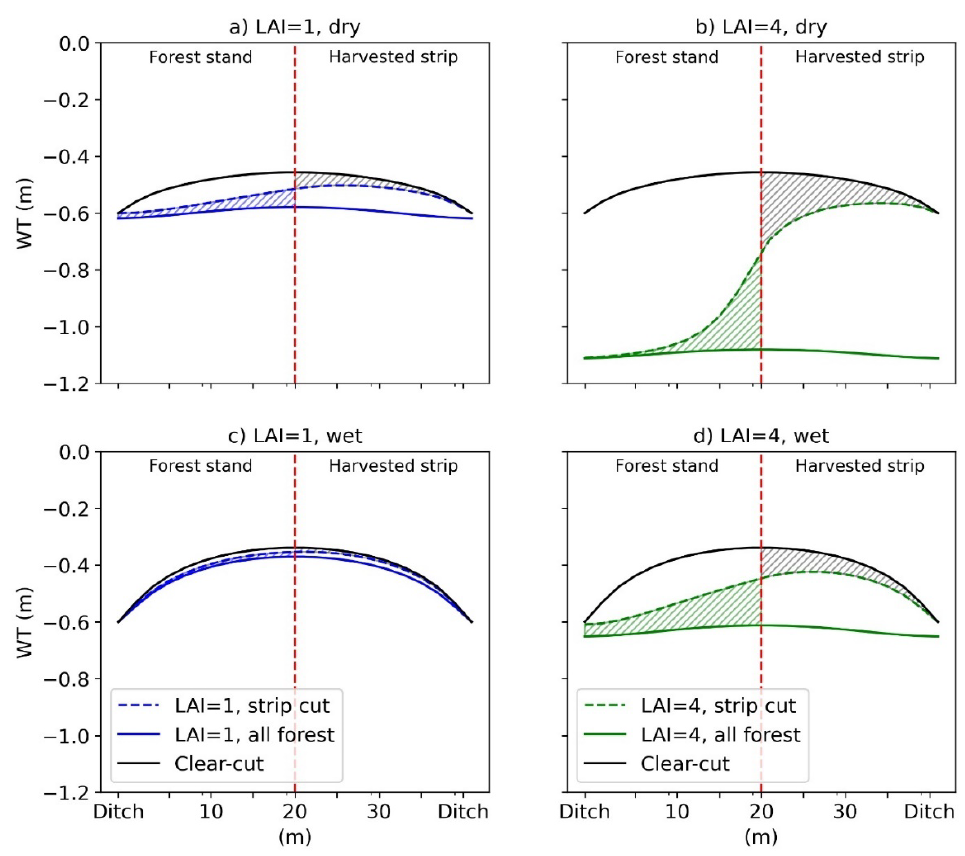
Figure A2. Cross-sectional (y = 50 m in Figure 5), momentary simulated WTs at the end of August during a dry summer ( a , b ) and a wet summer ( c , d ) in Carex peat areas with a − 0.6 m ditch depth, LAI = 1, and LAI = 4. The edge between the forest and harvested strips is separated by the red, dashed lines. The blue (LAI = 1) and green (LAI = 4) hatched areas indicate the edge effects of the harvested strip on the forest stand. The gray hatched areas indicate edge effects of the forest stand on the harvested strip.